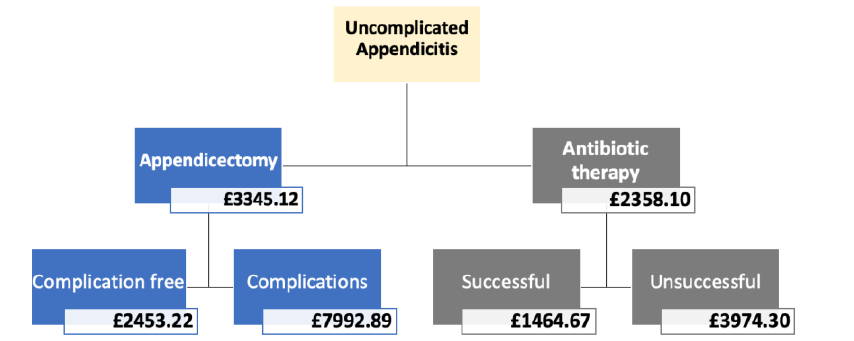
Figure 2. Costs extracted from the decision tree.